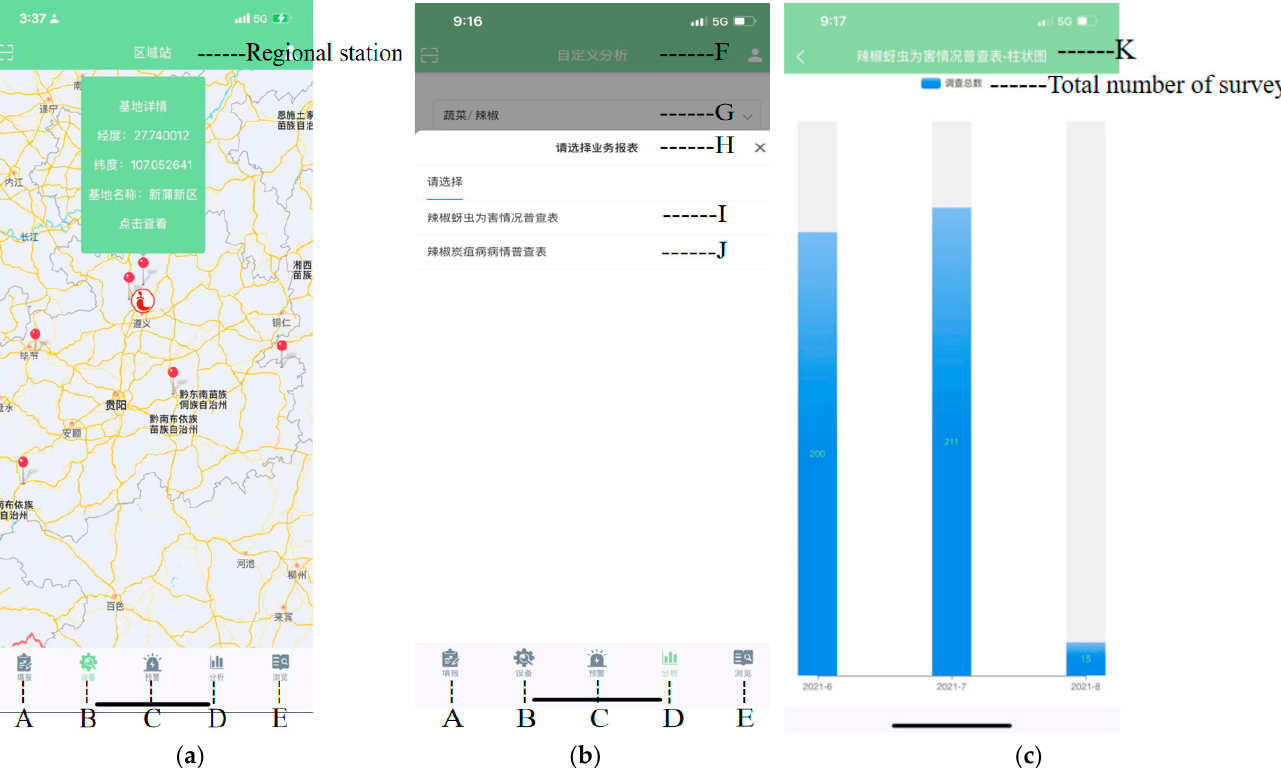
Figure 6. Interfaces of the epidemic monitoring system for hot pepper in Guizhou. (A) Front page; (B) Digital monitoring and early warning for disease and pests; (C) Thematic graphic display sub- system; (D) Disease and pest knowledge base; (E) Conference display management; (F) Information communication subsystem; (G) IoT data collection subsystem for disease and pests; (H) National plant protection professional statistical system; and (I) Basic data management.